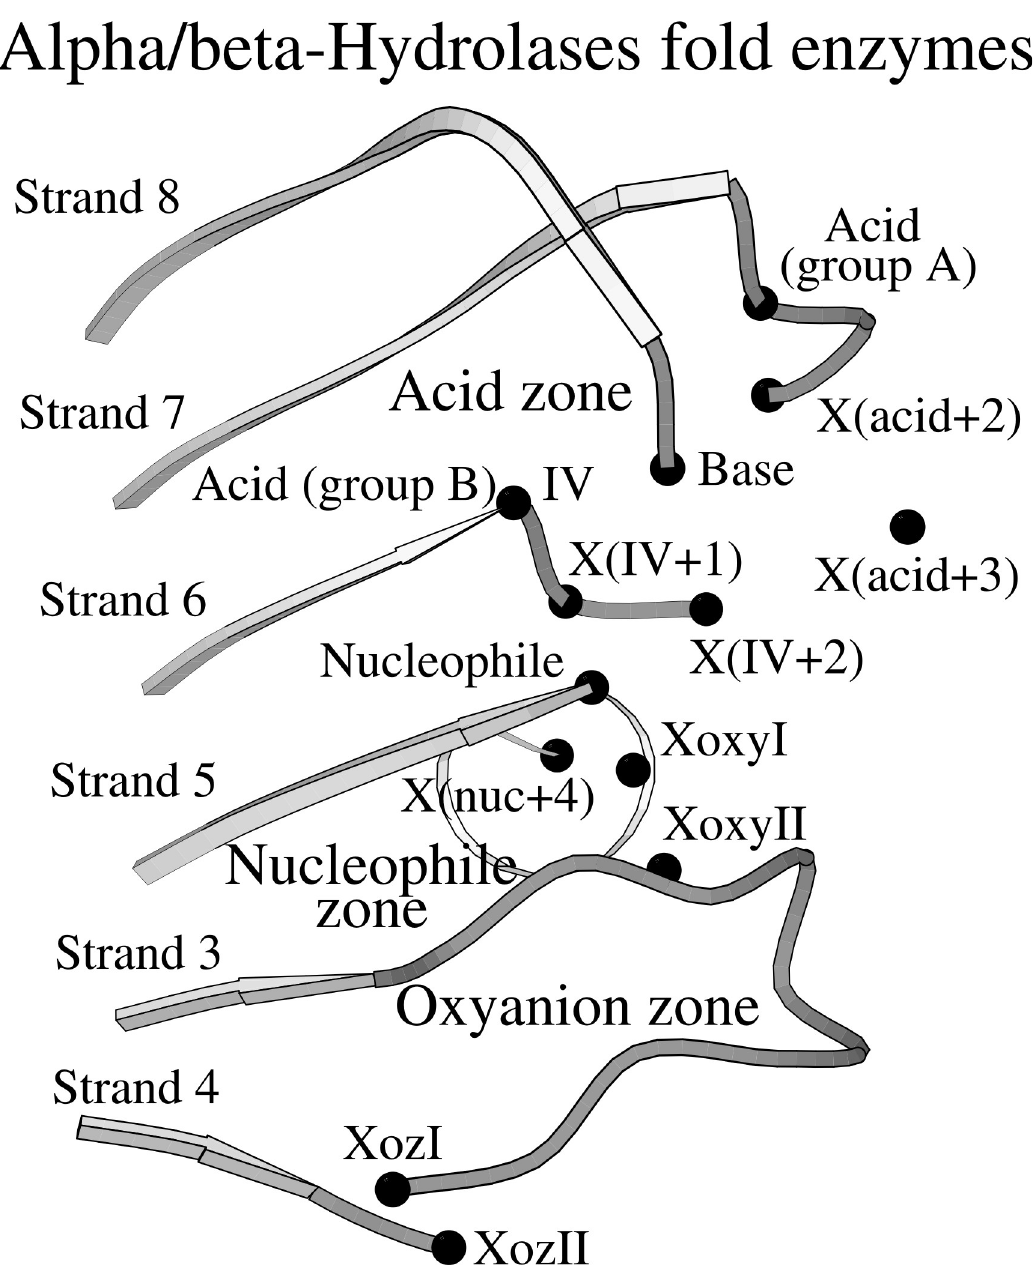
Fig 1. Conserved structural motifs at the catalytic site of ABH fold enzymes. Most key features of the catalytic machinery are coordinated by conserved structural organizations within the same plane as the central β -sheet of the ABH fold. Specifically, the catalytic acid (“Acid”), which is located at the turn that follows strand β 7 (“group A”) or at the C-terminus of strand β 6 (“group B”, position “IV”), is coordinated by the structural organization that is called “Catalytic acid zone” (“Acid zone”), while the catalytic nucleophile (“Nucleophile”) and the two residues that help form the oxyanion hole (“XoxyI” and “XoxyII”) are coordinated by the overlapping “Nucleophile zone” and “Oxyanion zone”. The catalytic histidine (“Base”) is located at a flexible loop that follows strand β 8 and is linked with the β -sheet at the C-terminus of strand β 6. The residues of the catalytic machinery, two conserved residues of Oxyanion zone (“XozI” and “XozII”), four residues of catalytic acid loops (“X(acid+2)”, “X(acid+3)”, “X(IV+1)” and “X (IV+2)”) and one residue of the nucleophile elbow (“X(nuc+4)”) are indicated with black dots.